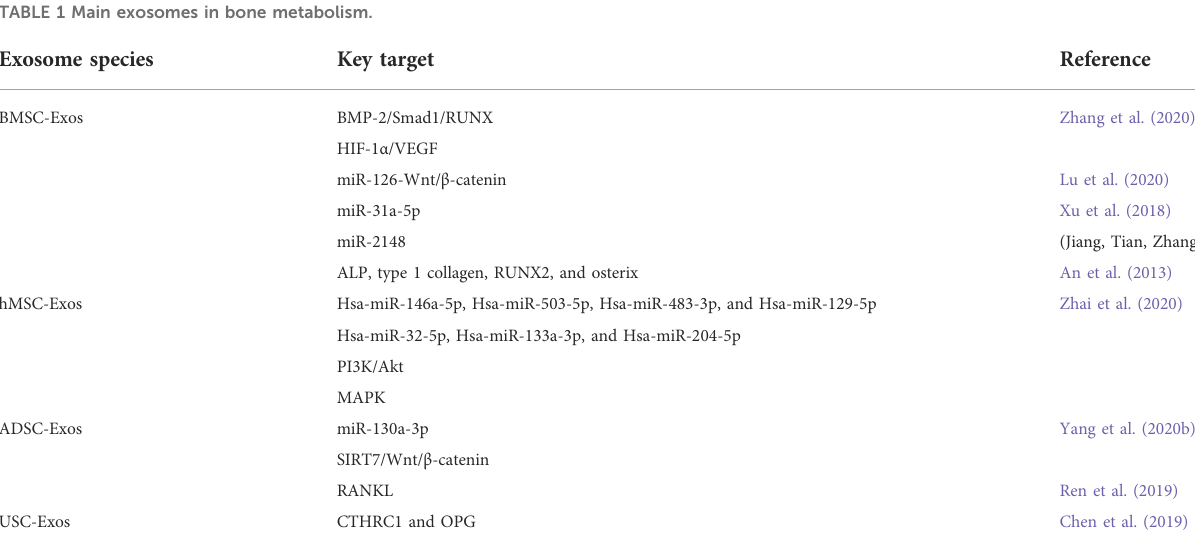
TABLE 1 Main exosomes in bone